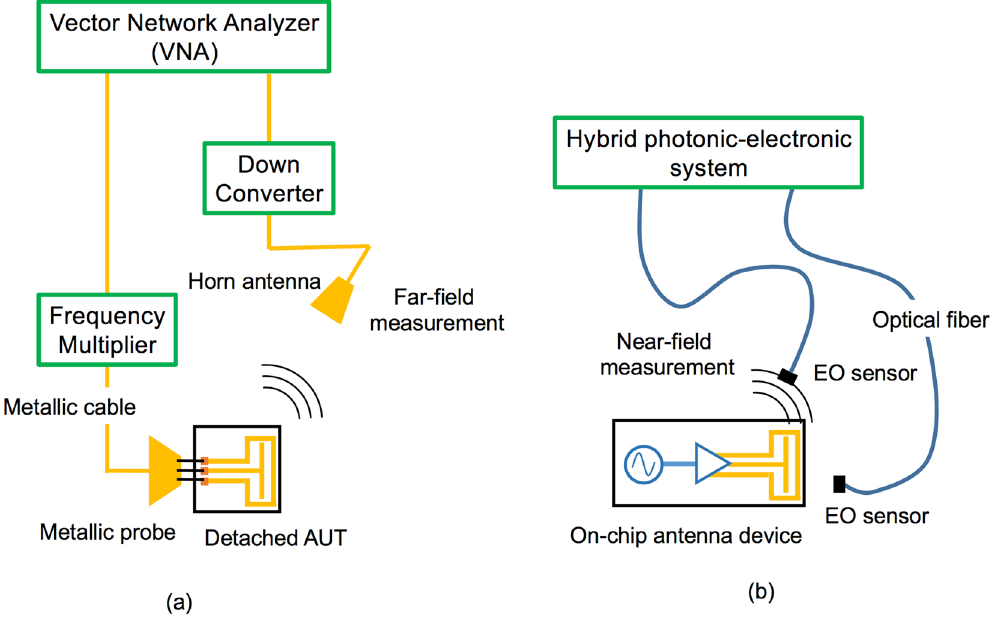
Figure 1. Comparison of the conventional and proposed measurement schemes. ( a ) Conventional system using a network analyzer and the ( b ) proposed